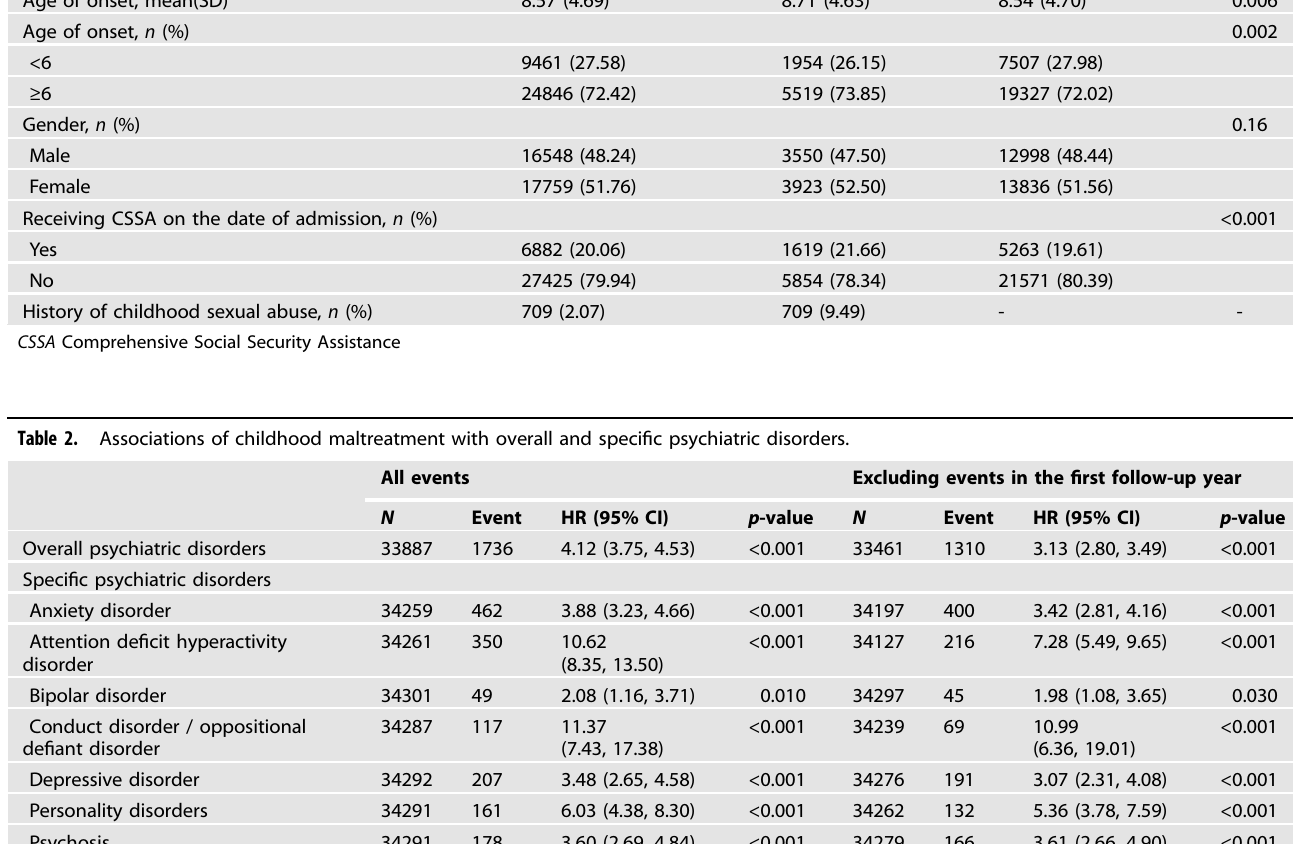
Table 3a – c show the results of comparative analysis of